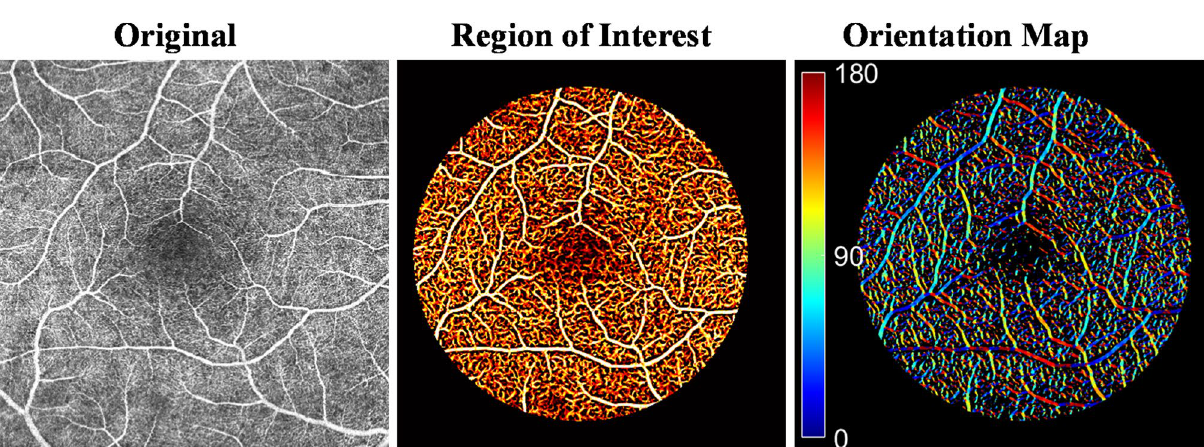
Figure 3. Visualization of retinal microvascular orientation in the region of interest after vesselness filter and binary filter. Dark blue and red indicate 0º and 180º for those horizontal vessels and green indicates 90º for those vertical vessels. The image processing was operated on the full-thickness (non-segmented) en face OCTA